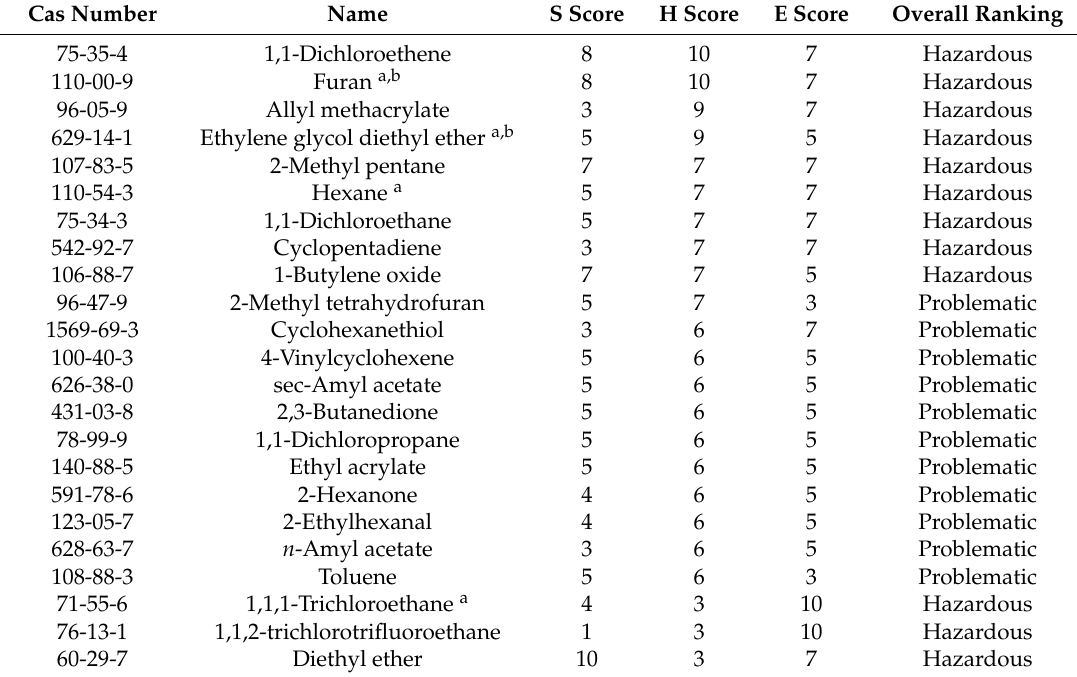
Table 4. Short list with selected solvents from candidates list for tetramethyl oxolane (TMO)